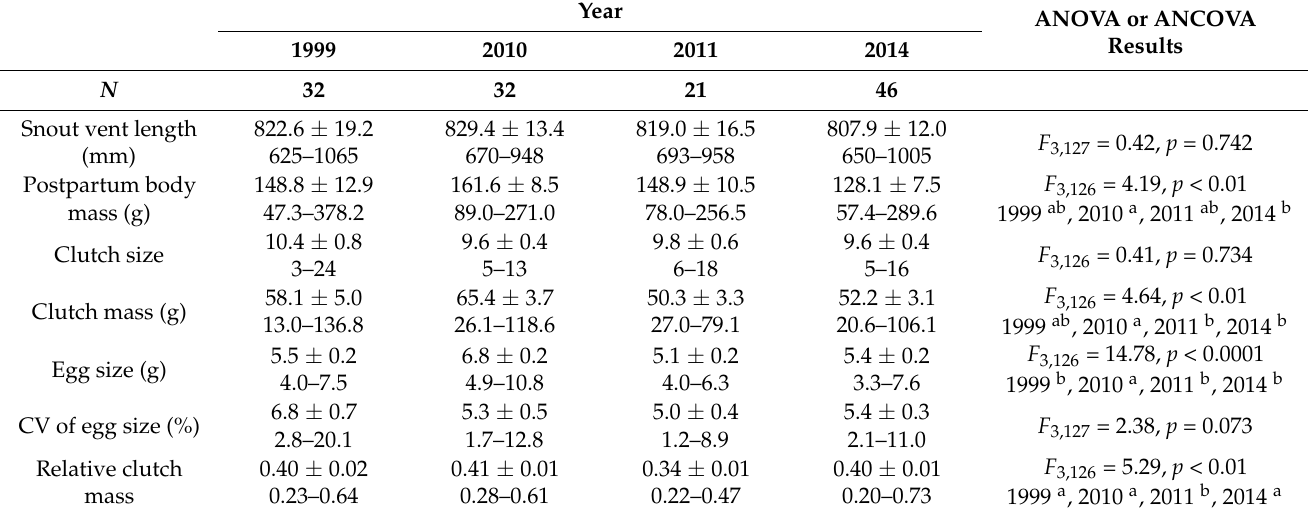
Table 1. Descriptive statistics, expressed as mean ± SE and range, for reproductive traits of female L. rufozonatus collected in 1999, 2010, 2011, and 2014, and results of one-way ANOVA [snout vent length (SVL) and coefficient of variation (CV) of egg mass] and ANCOVA (postpartum body mass, clutch size, clutch mass, and egg size with SVL as the covariate, and relative clutch mass with postpartum body mass as the covariate). Years with different superscripts differ significantly (Tukey’s post hoc test, α = 0.05, a >